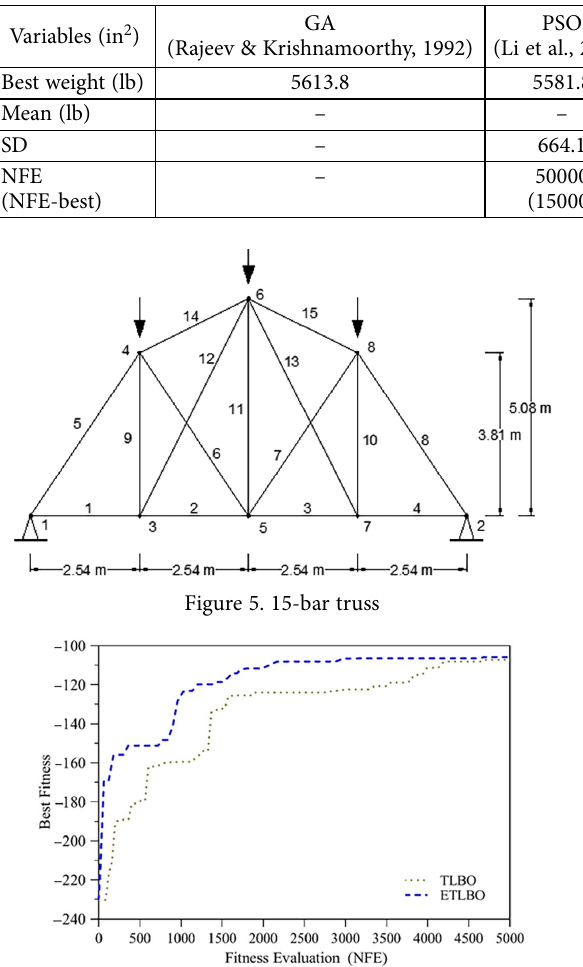
Figure 6. Convergence comparison of ETLBO vs. TLBO for the 15-bar truss